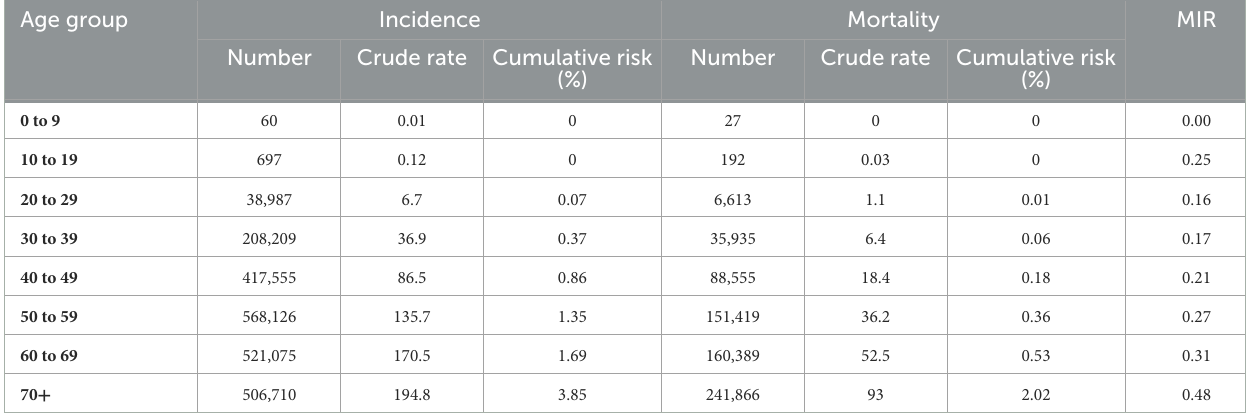
TABLE 2 Global BC incidence and mortality metrics in all-age number, crude rate, cumulative risk, and MIR for age groups. Age group Incidence Mortality MIR Number Crude rate Cumulative risk Number Crude rate Cumulative risk (%)